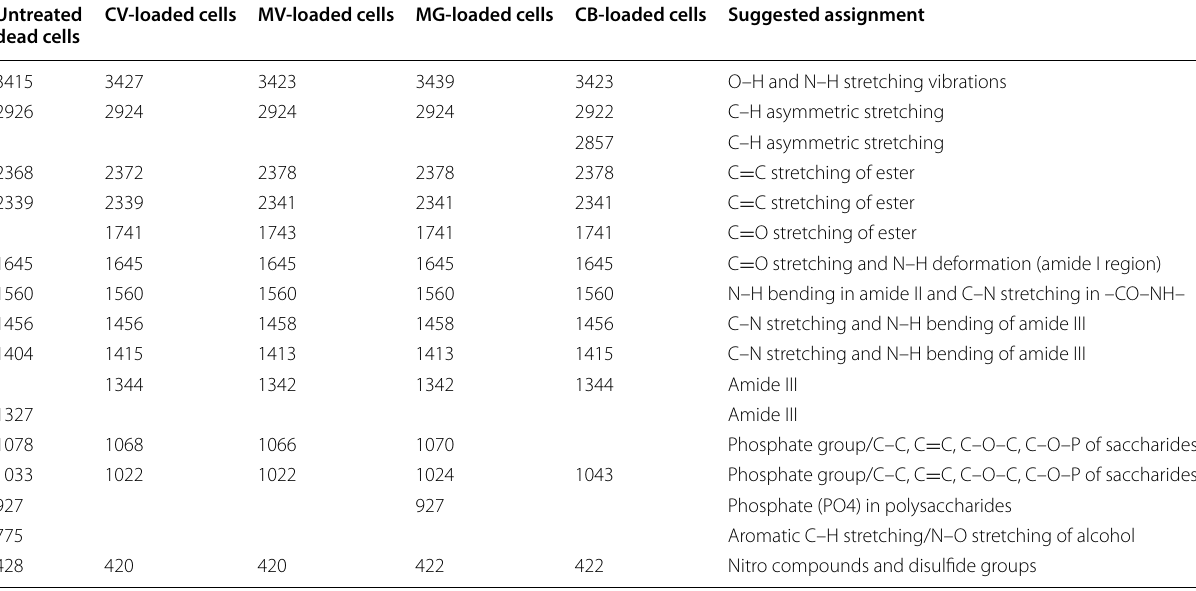
Table 2 Exemplary FTIR band positions (cm-1) of dead cells of isolate SWUSI4 before and after treatment with CV, MV, MG and